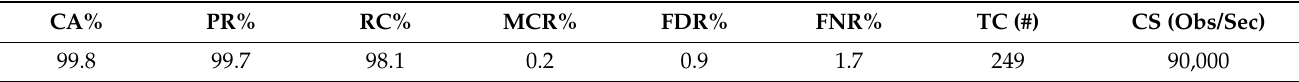
Table 7. Summary of System Evaluation Results for